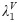
The Comparison of the segmentation results for different values λ1V in the MGDF model.This value is set to 1.0, 1.05 and 1.1 for (A), (B) and (C), respectively.